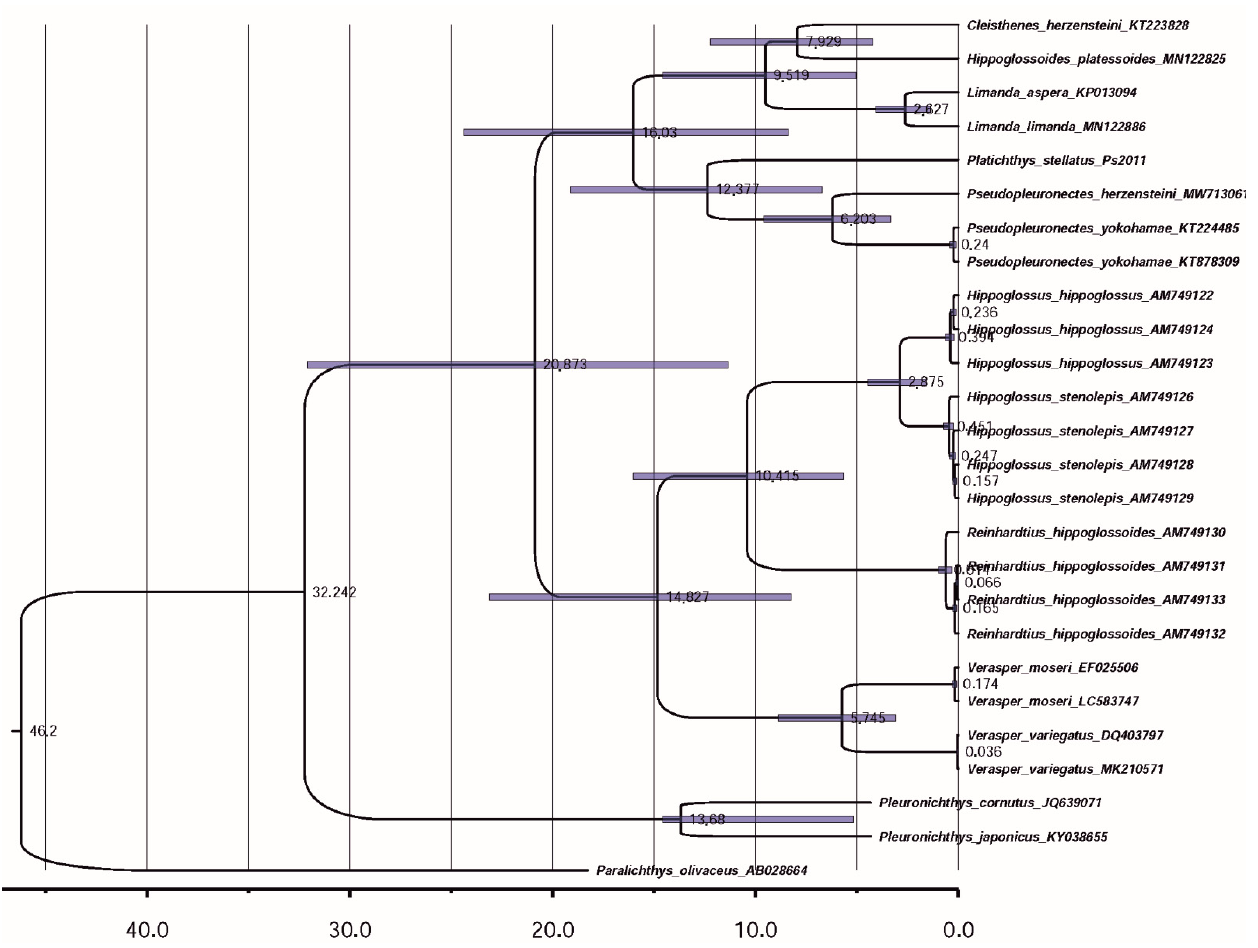
Figure 4. CA-based time-tree reconstruction via BEAST-2 and FigTree utilities that based on 13 PCG sequences of 26 analyzed representatives of flounder family Pleuronectidae and the outgroup. Details for the simulation of the tree in the current image are given in the text. Besides the nodes, their ages are given after rooting the tree with the outgroup taxon Paralichthys olivaceus and converting the scale in node ages to root age, which equated to 46.2 Mya. Bars are representing CA 95%HDP for the node ages.